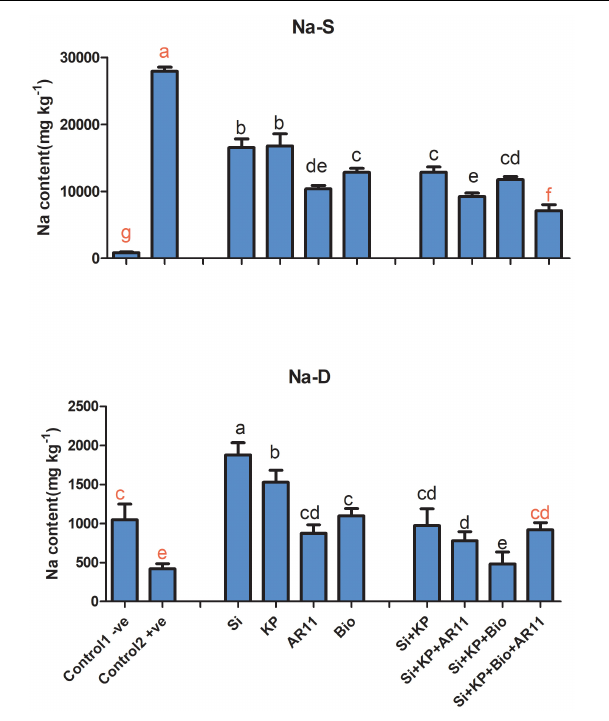
FIGURE 4 | Influx of Na + ion content in rice shoots subjected to salt and drought stresses following AR11, Si, K 2 HPO 4 , and biochar inoculation. (-S), salt; (-D), drought. Error bars represent standard deviations. Each data point represents the mean of at least three replications. Bars with different letters are significantly different from each other at P ≤